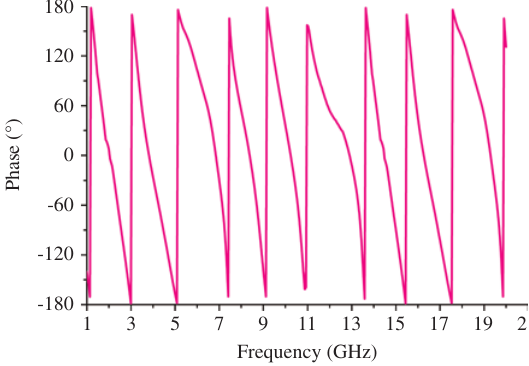
Figure 11: Pulse transmission analysis in different orientations of the proposed SWB antenna.